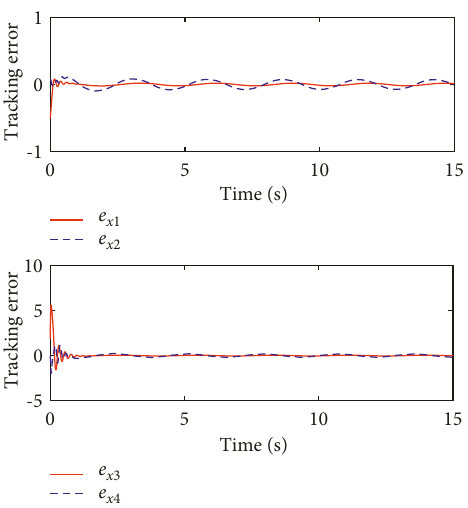
Figure 21: Tracking errors of q